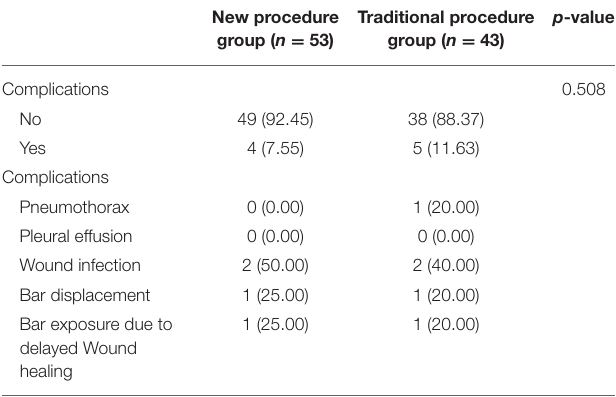
TABLE 3 | Complications in new procedure and traditional procedure group. New procedure Traditional procedure group ( n = 53) group ( n =